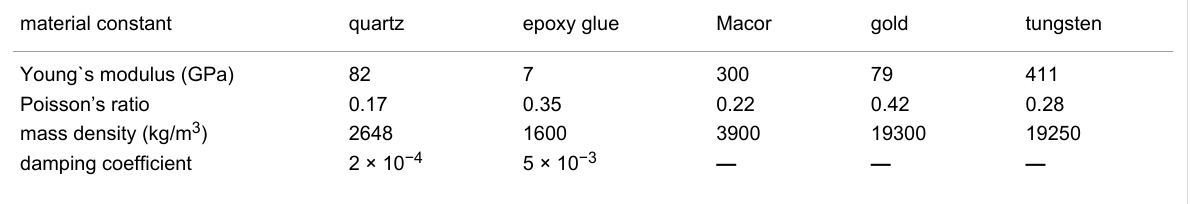
Table 1: Material properties used for finite element calculations. Since significant damping occurs only inside the quartz and, in particular, the epoxy glue, no damping coefficient is defined for Macor, gold, and tungsten. material constant quartz epoxy glue Young`s modulus